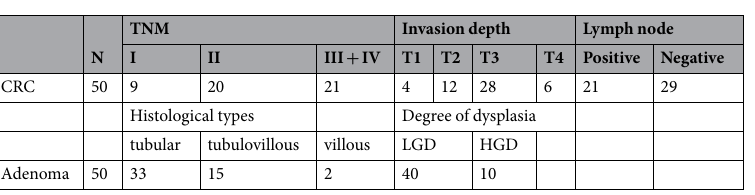
Table 2. Basic information of patients with adenoma and CRC. LGD: lower grade dysplasia; HGD: high grade